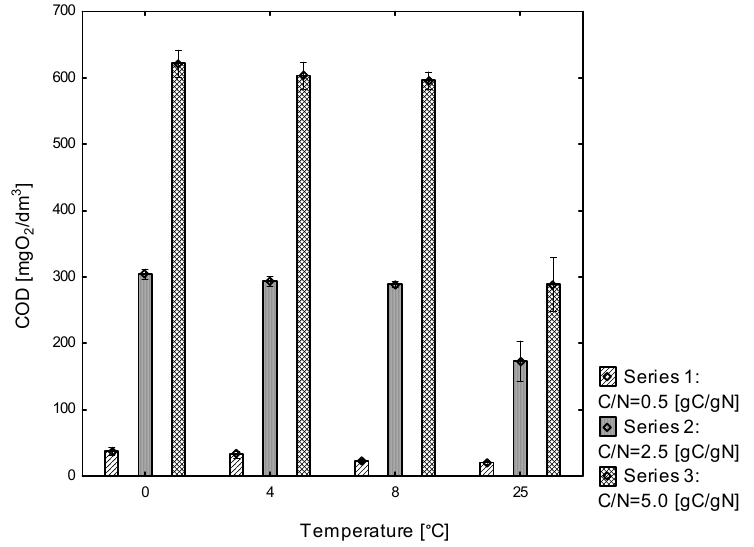
Figure 9. Influence of the C/N ratio on the organic compound concentrations in treated wastewater.